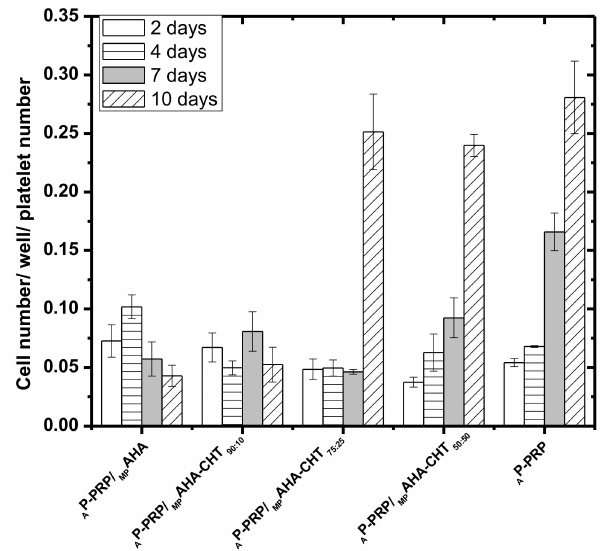
Figure 5. The proliferation profiles of h-AdMSCs cultured in the associations and A P-PRP as a function of time. A P-PRP was used as control. The concentration of platelets in A P-PRP was 495.000 ± 18.810 pq / mm 3 . Except in A P-PRP / MP AHA and A P-PRP / MP AHA-CHT 90:10 , the proliferations were statistically (* p < 0.05) similar to A P-PRP after 10 days of